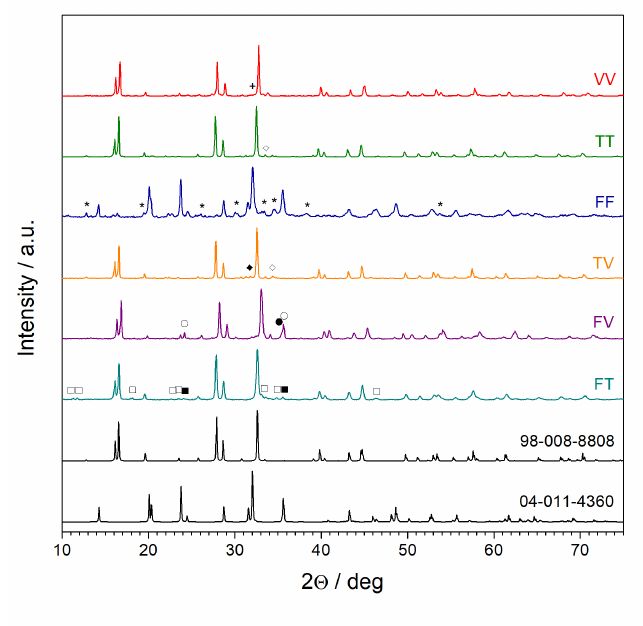
Figure 2. XRD patterns of nanocrystallized NASICON-like glasses. Na 3 V 2 ( PO 4 ) 2 F 3 NASICON (ICSD card no. 98-008-8808) and γ —Na 3 Fe 2 ( PO 4 ) 3 NASICON analogue patterns (ICDD 04-011-4360) are given as reference. Reflexes that could not be ascribed to either of the aforementioned phases were identified as coming from the following ones: crosses—monoclinic NaVO 3 (ICSD 98-006-3479), open diamonds—orthorombic Na 5 Ti ( PO 4 ) 2 OF (ICDD 01-079-0411), full diamonds—cubic NaF (ICDD 04- 019-2673), stars—orthorombic Na 2 FePO 4 F (ICSD 98-019-4076), open circles—hexagonal V 2 O 3 (ICSD 98-000-1874), full circles—cubic V 3 O 4 (ICDD 04-002-6772), open squares—orthorombic Na 4 TiP 2 O 9 (ICSD 98-003-9702), full squares—hexagonal Fe 2 O 3 (ICSD